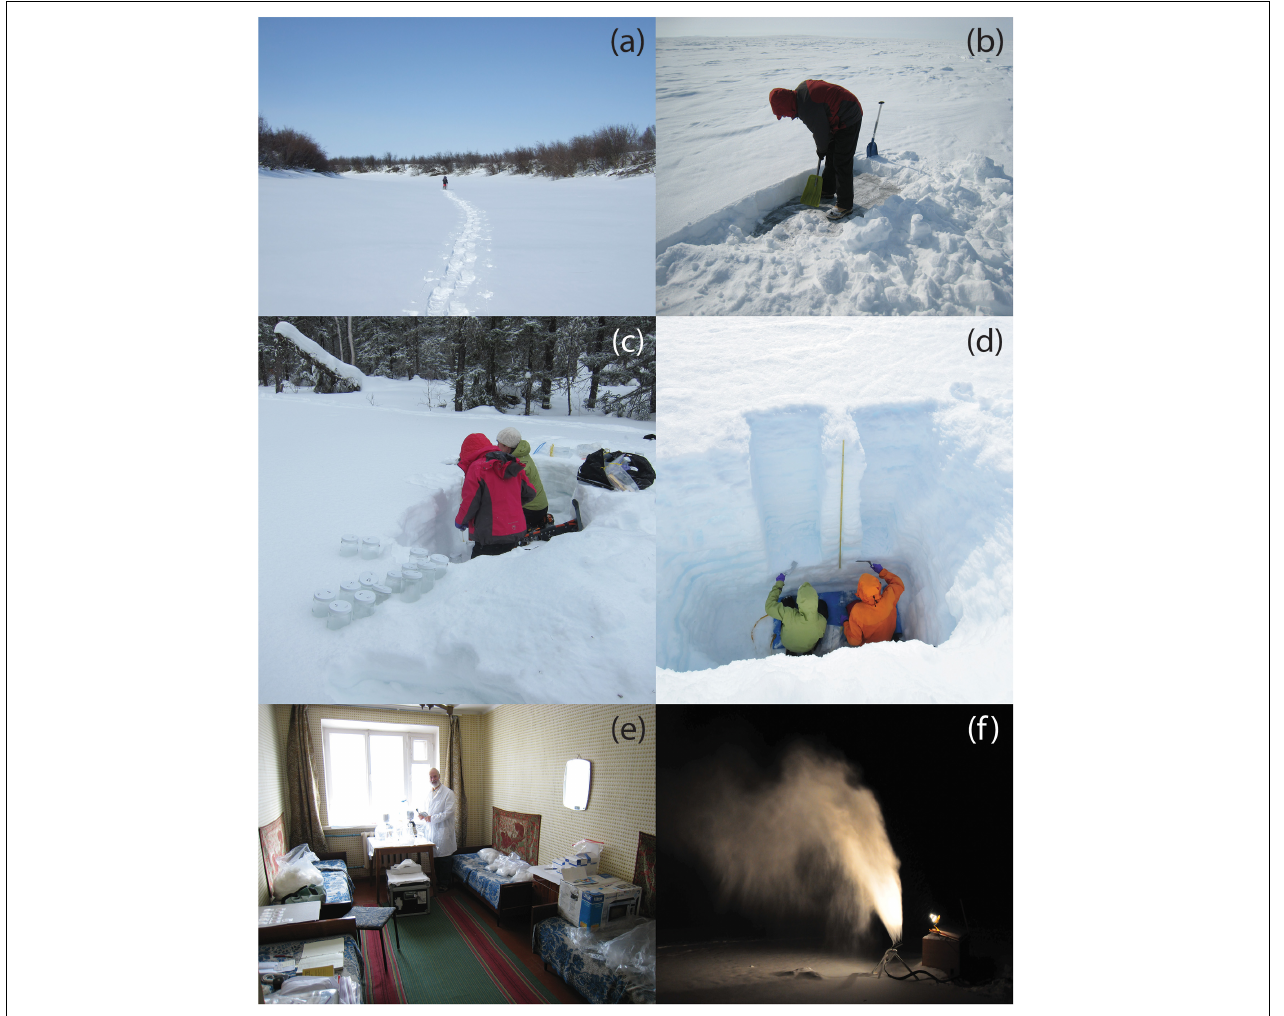
FIGURE 1 | Photos from fieldwork. (a) In the Kolyma lowland, Yakutia. (b) Rich Brandt on a frozen lake in Arctic Canada. (c) Cheng Dang and Sarah Doherty in Manitoba. (d) With Sarah Doherty, finding buried summer melt-layers near Dye-2 in the percolation zone of South Greenland (photo by Rich Brandt). (e) Tom Grenfell filtering snowmelt in a hotel room in Tiksi near the Lena Delta. [Written informed consent has been obtained from him to publish this picture]. (f) Making artificial snowpacks in the Adirondack Mountains (Rich